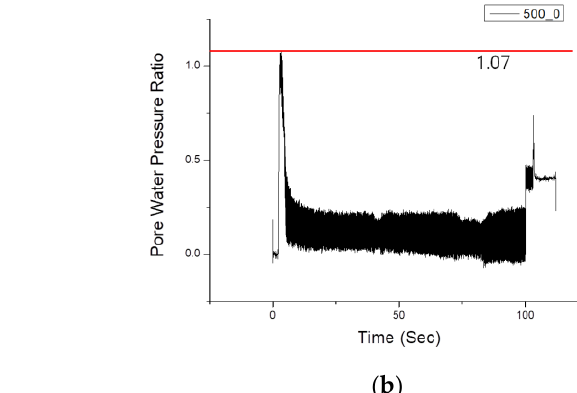
Figure 13. Grouting mixing ratio of 0.5 and separation distance of 0 cm: ( a ) Settlement ( b ) Pore Water Pressure Ratio.